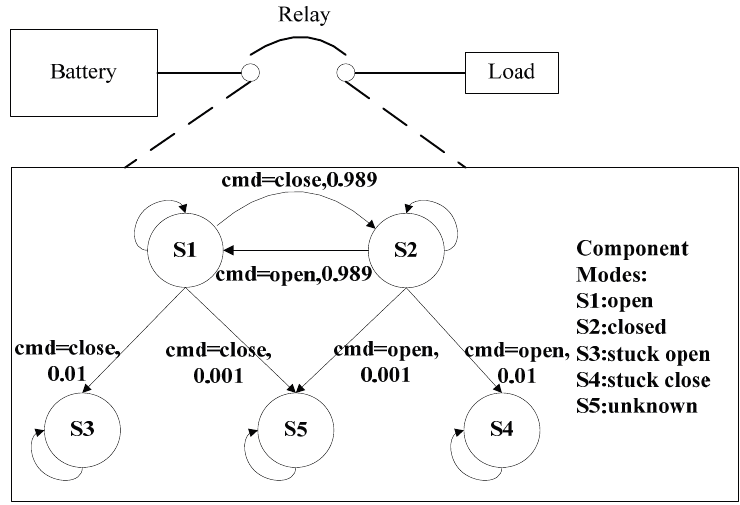
Figure 1. A simple circuit consisting of a battery, relay and a